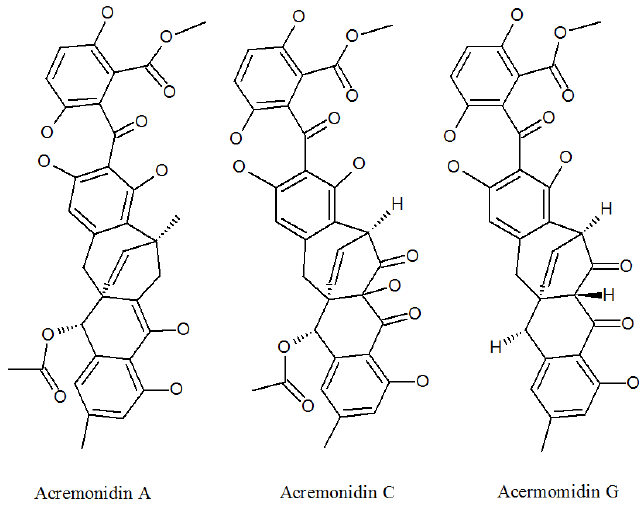
Figure 2. The structures of acremonidins.